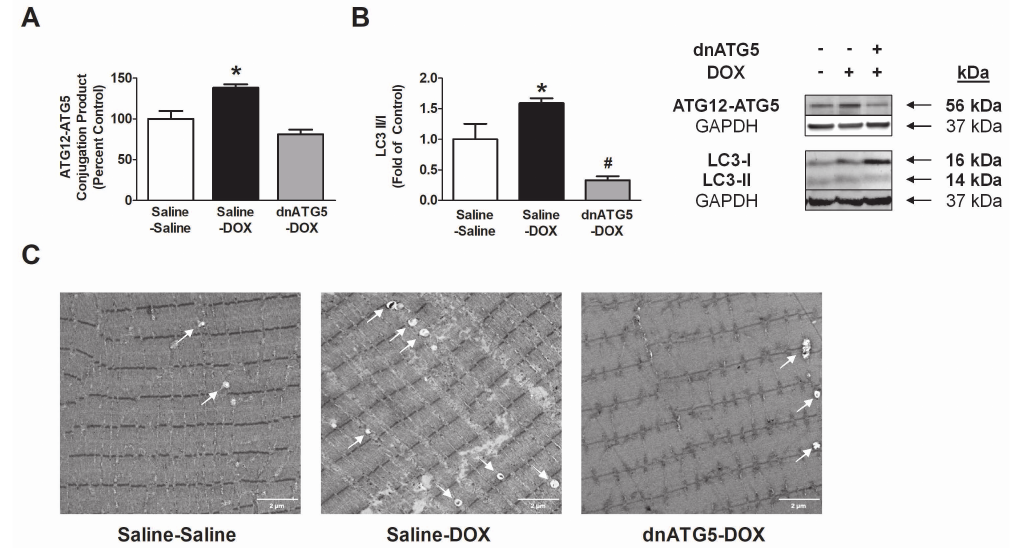
Figure 2. Protein expression of ( A ) the ATG12-ATG5 conjugation product and ( B ) light chain 3 (LC3)-II / I ratio. Values are represented as means ± SEM. Representative Western blot images are shown to the right of the graph. * significantly di ff erent versus all groups ( p < 0.05). # significantly di ff erent versus Saline-Saline ( p < 0.05). ( C ) Representative soleus muscle electron microscopy images. White arrows within each soleus muscle image indicate autophagic vacuoles. Soleus ultrastructure appears identical between the Saline-Saline and dnATG5-doxorubicin (DOX)